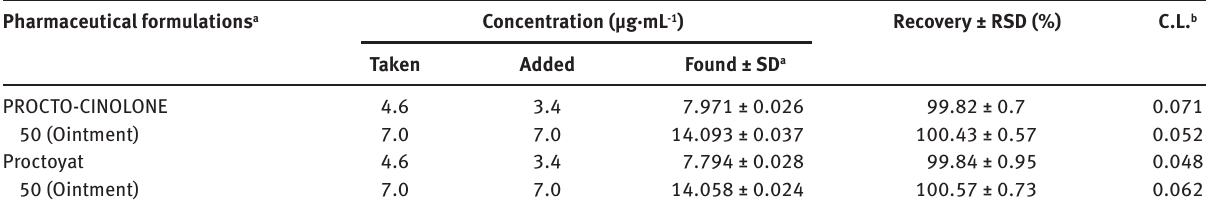
Table 8: Spiked procedure – assessment the determination of Al 3+ in dosage forms using the proposed method Pharmaceutical formulations